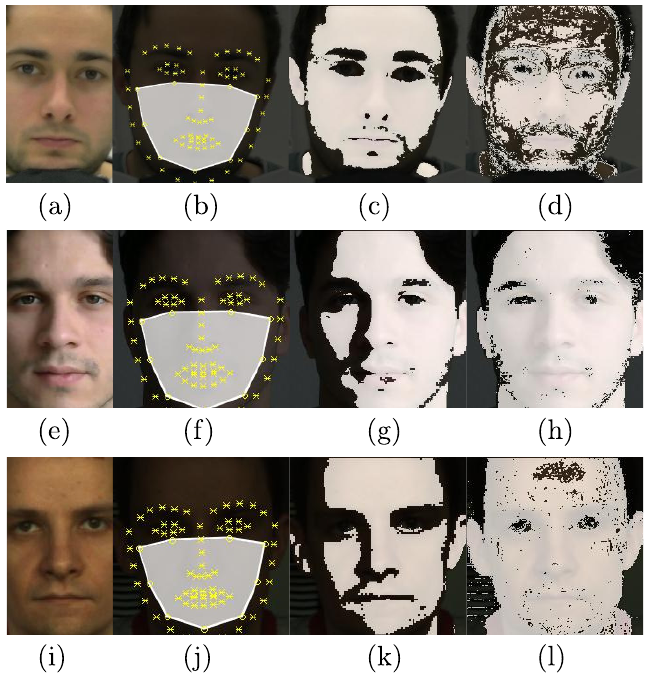
Figure 1. Results of the region of interest (ROI) localization on the selected recordings from stud- ied data sets: recording P1LC3 from PBDTrPPG using ( a ) VK, ( b ) VK-LMK, ( c ) VK-Conaire, ( d ) VK-RGBHCbCr; recording angelo_resting from LGI–PPGI–FVD using ( e ) VK, ( f ) VK-LMK, ( g ) VK- Conaire, ( h ) VK-RGBHCbCr; recording 01-01 from PURE ( i ) VK, ( j ) VK-LMK, ( k ) VK-Conaire, ( l ) VK-RGBHCbCr. VK: Viola-Jones combined with ROI width reduction and Kanade–Lucas–Tomasi tracker; VK-Conaire: Viola-Jones combined with skin detector based on the maximization of mutual information and Kanade–Lucas–Tomasi tracker; VK-LMK: Viola-Jones combined with landmarks detection and Kanade–Lucas–Tomasi tracker; VK-RGBHCbCr: Viola-Jones combined with RGB–H– CbCr skin-color segmentation and Kanade–Lucas–Tomasi tracker; FVP: Full Video Pulse Extraction rPPG